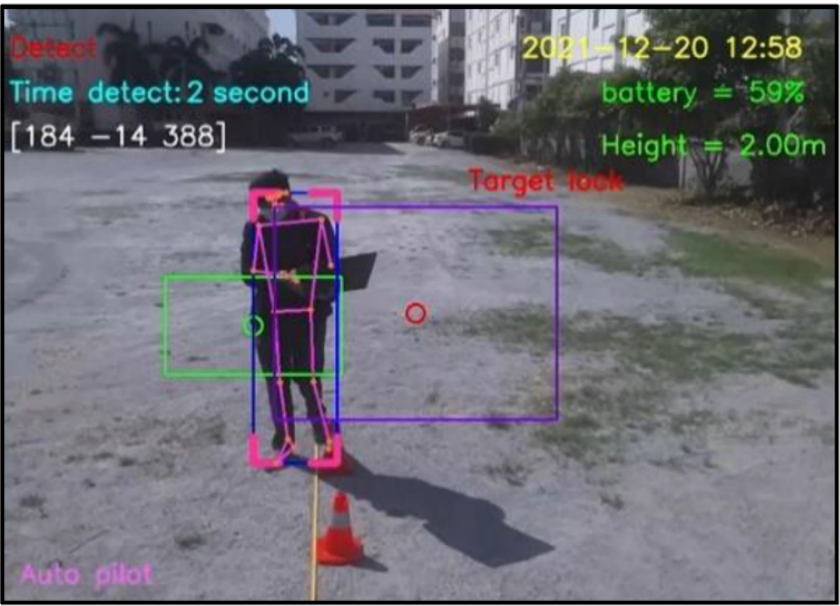
Figure 21. Exploration of light intensity for human motion detection at